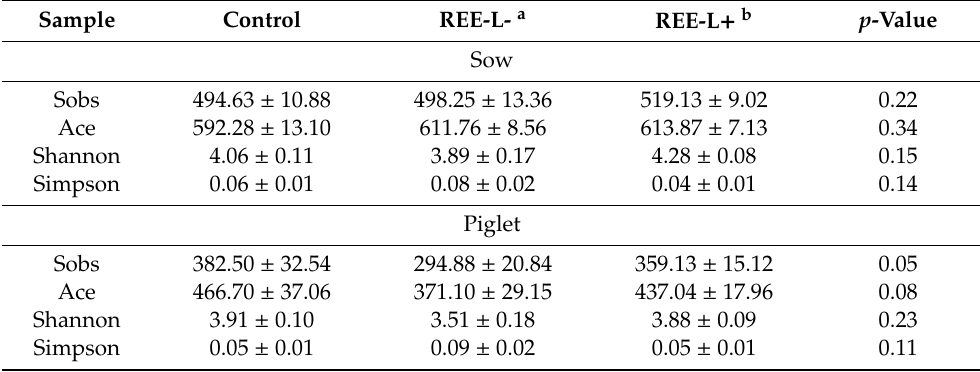
Table 4. Alpha-diversity of fecal microbiota from the lactating sows and the weaning piglets on day 21 of lactation.